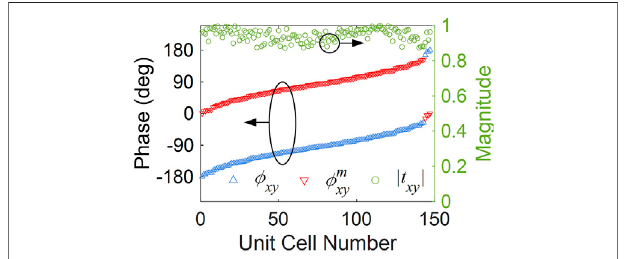
FIGURE 5 | The optimized unit cells ’ phase and magnitude results of t xy at 11